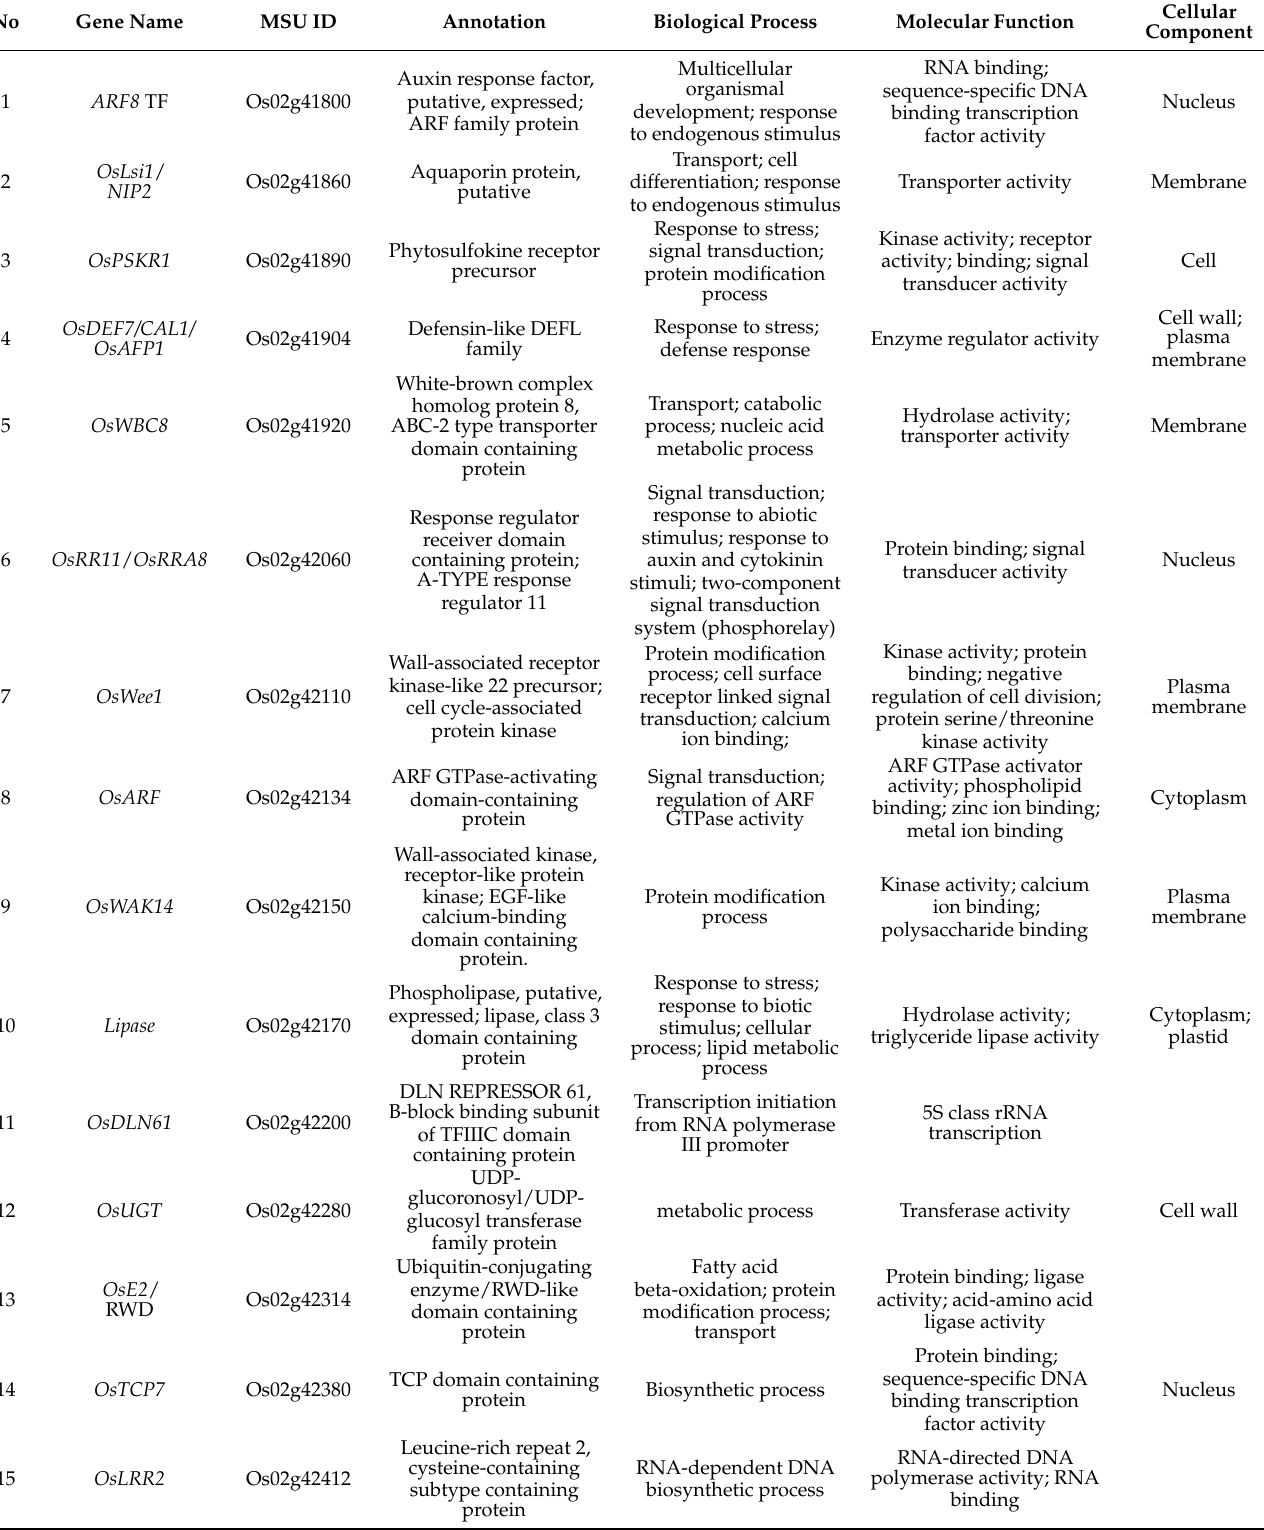
Table 2. Candidate genes harbored by the qROL-2-1 associated with radial oxygen loss in